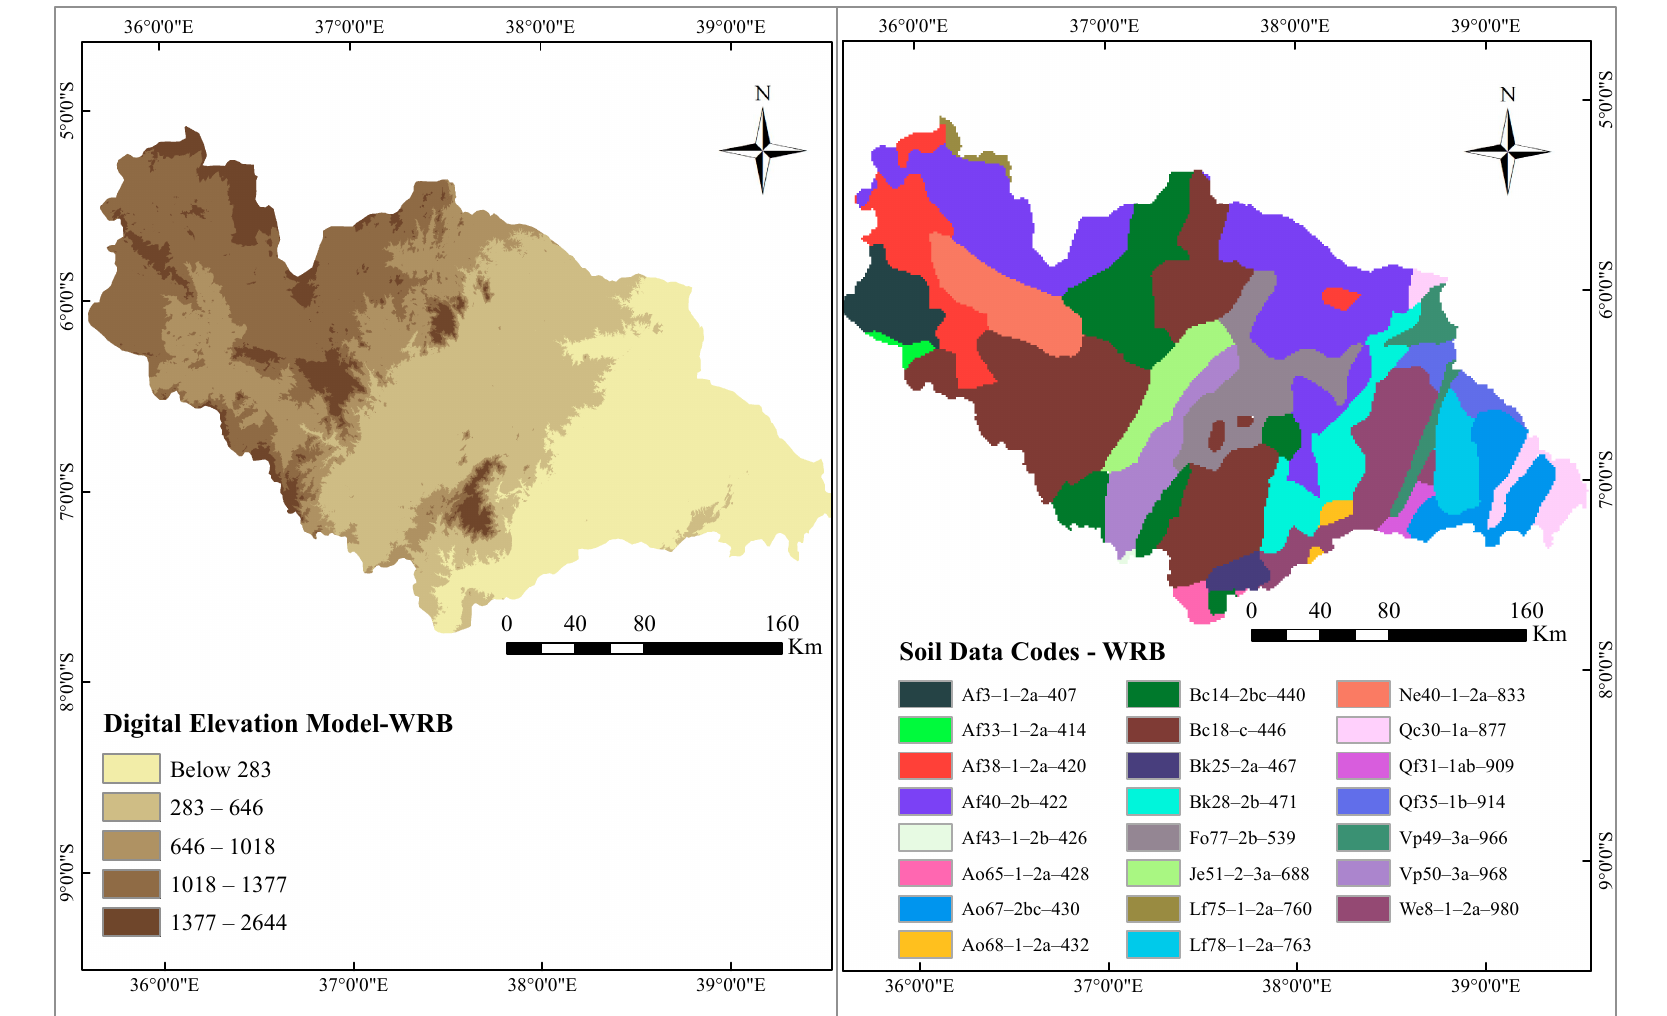
Figure 2. The topography and soil data used for the modelling of the Wami–Ruvu Basin.